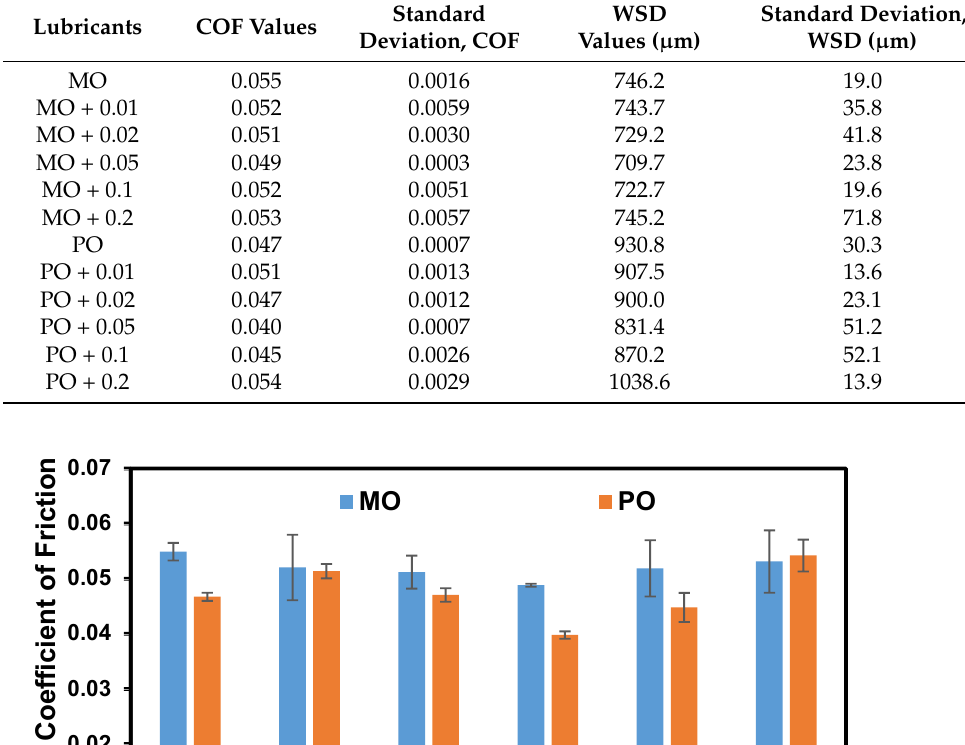
Table 5. Mean coefficient of friction and wear scar diameter of four-ball test and standard deviation.